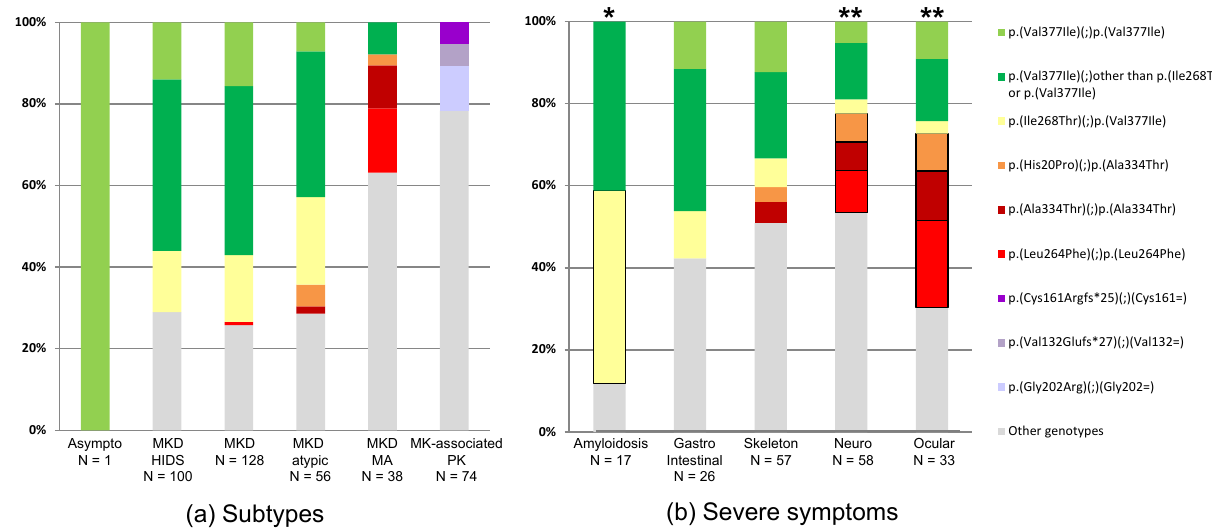
Figure 3. Distribution of the most frequent genotypes in mevalonate kinase-associated diseases patients. ( a ) According to mevalonate kinase-associated diseases subtypes. The mevalonate kinase-associated diseases (MKAD) subtypes are as reported: MKD: mevalonate kinase deficiency, systemic undefined; HIDS: hyper-IgD (Immunoglobin D) syndrome; MA: mevalonic aciduria; PK: porokeratosis. ( b ) According to the presence of severe symptoms defined as follows: gastrointestinal: adhesion, ascitis, bleeding, cholestasis, inflammatory bowel disease, and occlusion; skeleton: arthritis, bone sign, and dystonia; neurological: allodynia, ataxia, cerebral atrophy, language disorder, mental or motor retardation, paralysis, seizures, stroke, tremor, and meningitis; ocular: cataract, episcleritis, keratopathy, loss of vision, optic atrophy or neuritis, retinopathy, and uveitis. The boxed genotypes (alone for amyloidosis, or pooled for neurological and ocular symptoms) depict those significantly associated with severe manifestations within a given group of symptoms: * p < 0.001; ** p <